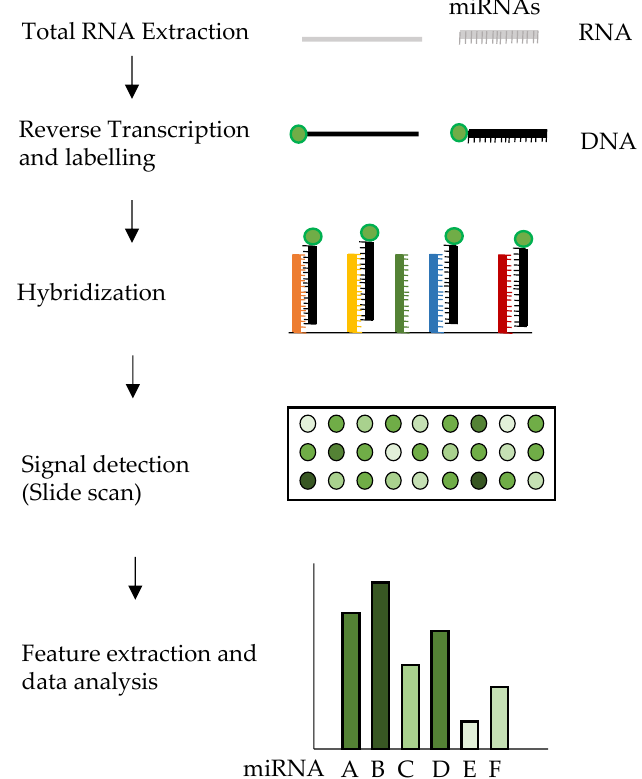
Figure 5. Diagram of miRNAs microarrays workflow. Labelling is usually done by incorporating a fluorophore during the reverse-transcription step. For the sake of simplicity, only one probe is shown per each miRNA type, but several identical probes are present in clusters on the microarray surface, and they bind to identical target miRNAs. Moreover, only 18 probe clusters are depicted on the microarray slide, but a microarray contains thousands of clusters, with up to 20 repetitions of the same cluster in different places of the slide. Wash steps are not